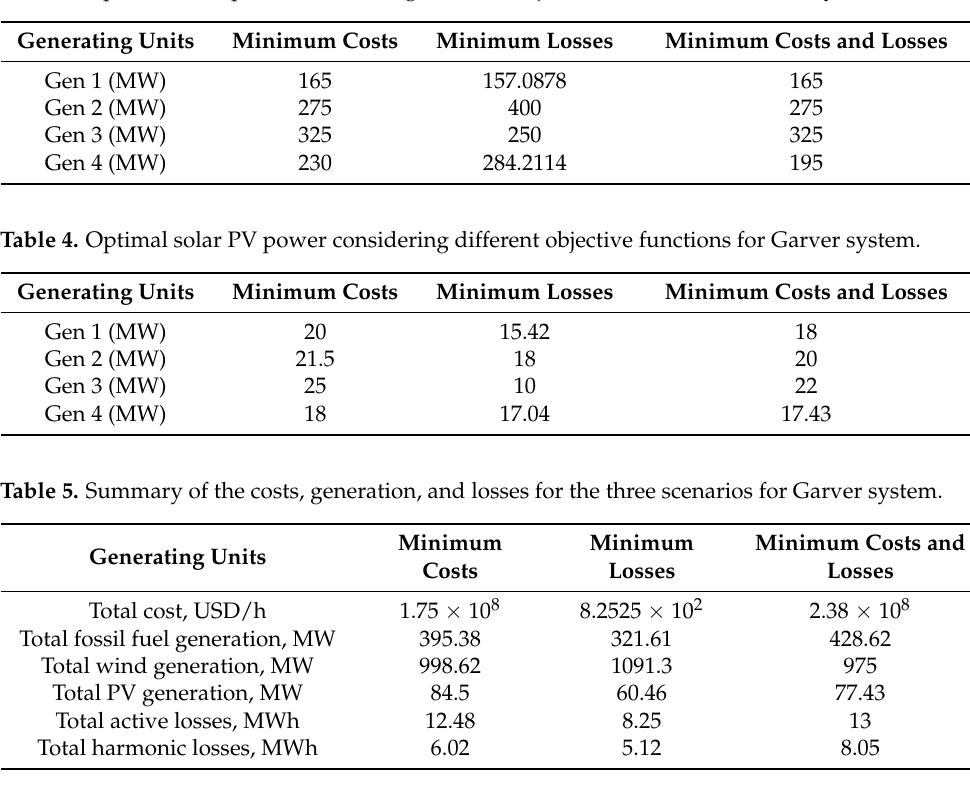
Table 3. Optimal wind power considering different objective functions for Garver system.